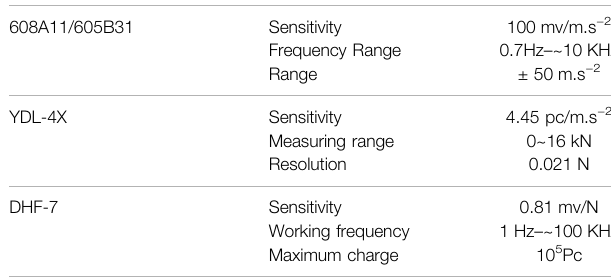
TABLE 2 | Main technical indicators of the